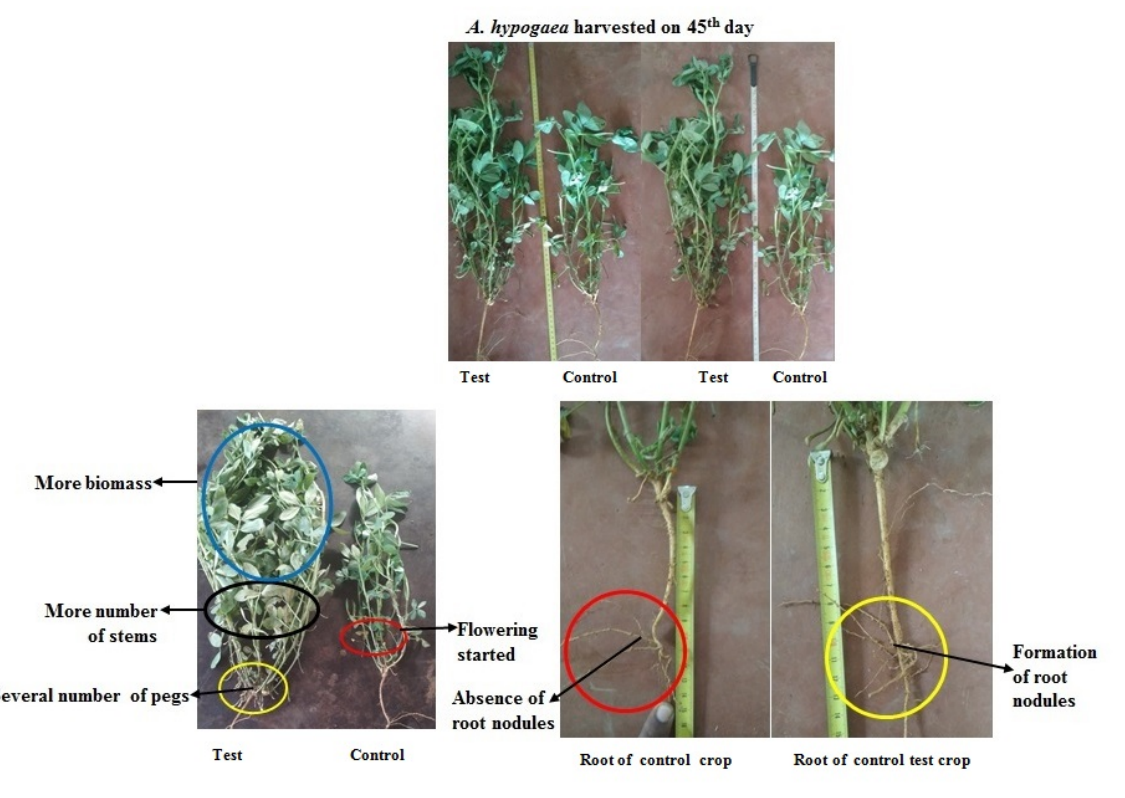
Figure 5. Physiological parameters of A. hypogaea under the influence of Kosakonia sp. MGR1.